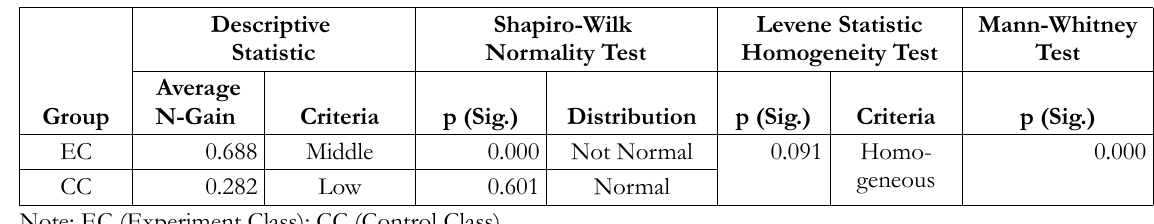
Table 8. The test result of descriptive statistic, Shapiro = Wilk normality, Levene statistic, and Mann-Whitney for increasing PSS in both